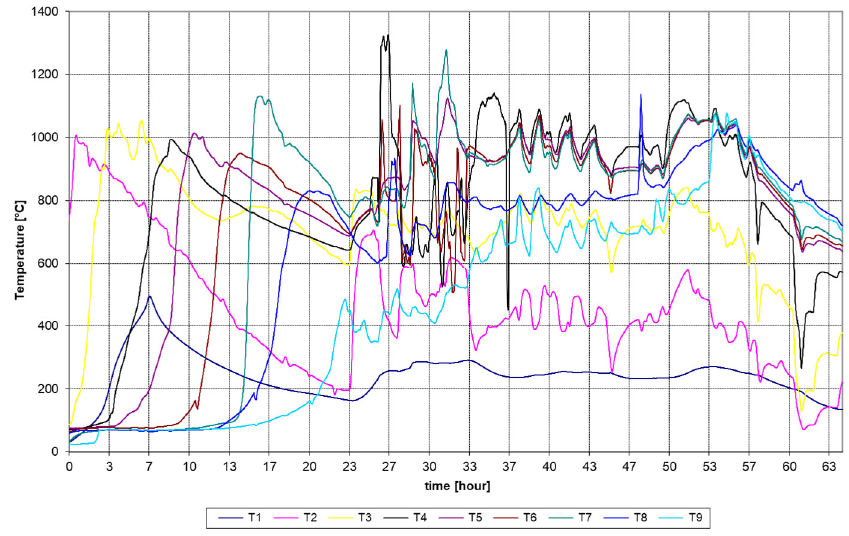
Figure 9. Temperature course in the gasification channel during the second experiment.